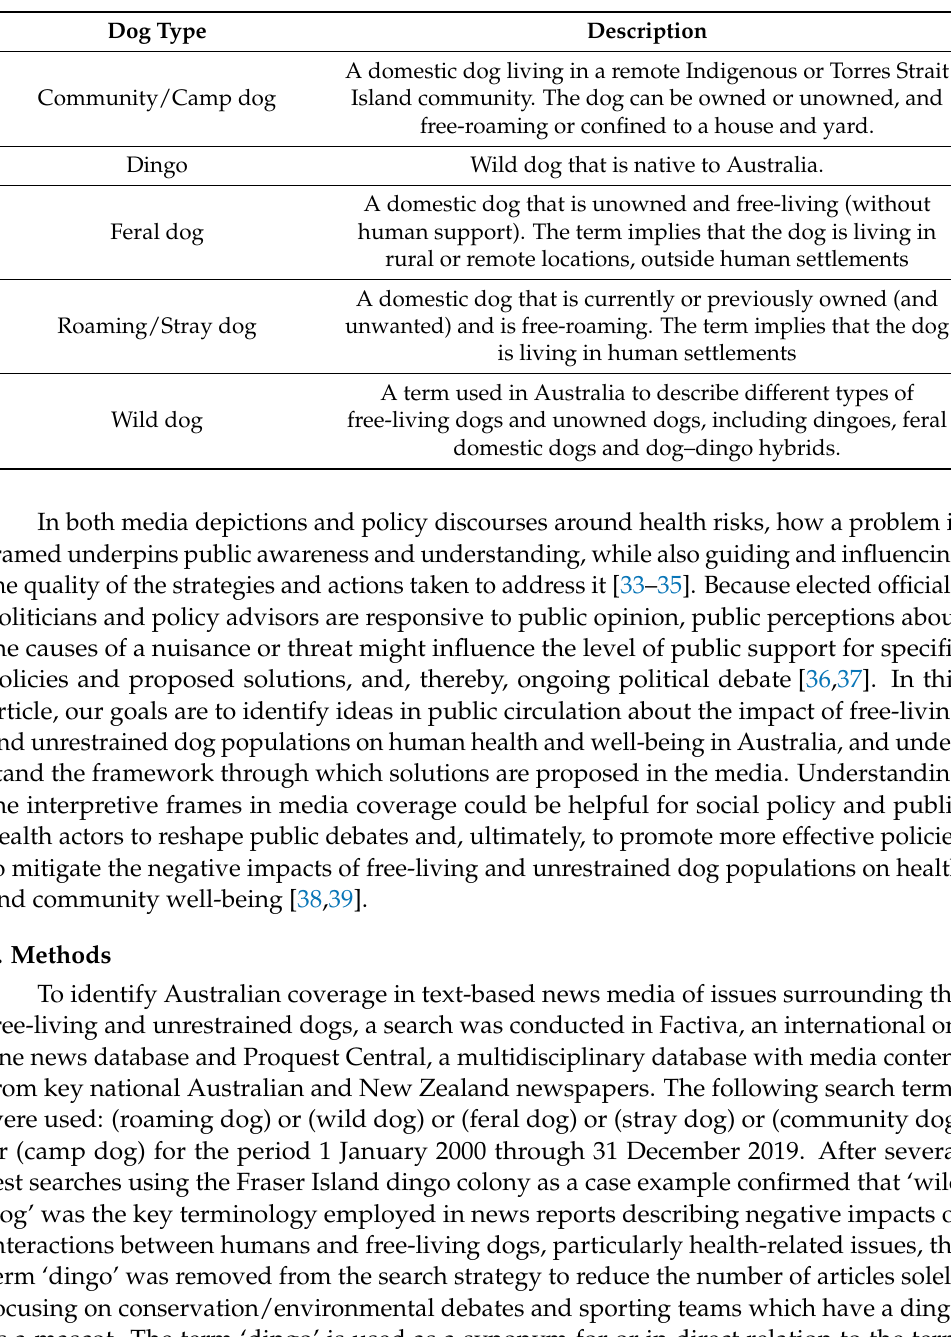
Table 1. Definitions of dog types in the context of a media analysis of the representations of dogs as an emerging public health issue in Australian